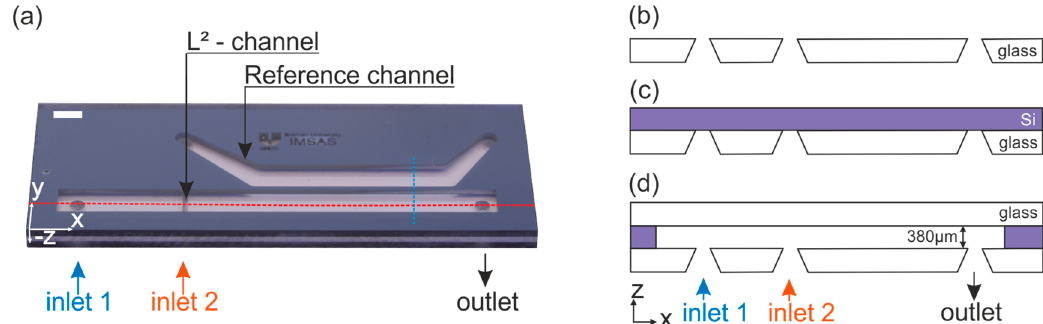
Figure 1. ( a ) Photograph of a glass-encapsulated silicon device with circular (inlet 1) and rectangular (inlet 2) fluidic connections. The scale bar at the upper left is 2 mm. ( b – d ) Fabrications steps including ( b ) powder blasting of glass, ( c ) anodic bonding of silicon to glass, DRIE of silicon, and ( d ) anodic bonding of a second glass-wafer. A cross-section of a plane-cut taken along the dotted red line of ( a ) is shown in ( d ). The sketch shows the inlets and outlet for the creation of two horizontally aligned (L 2 ) liquid